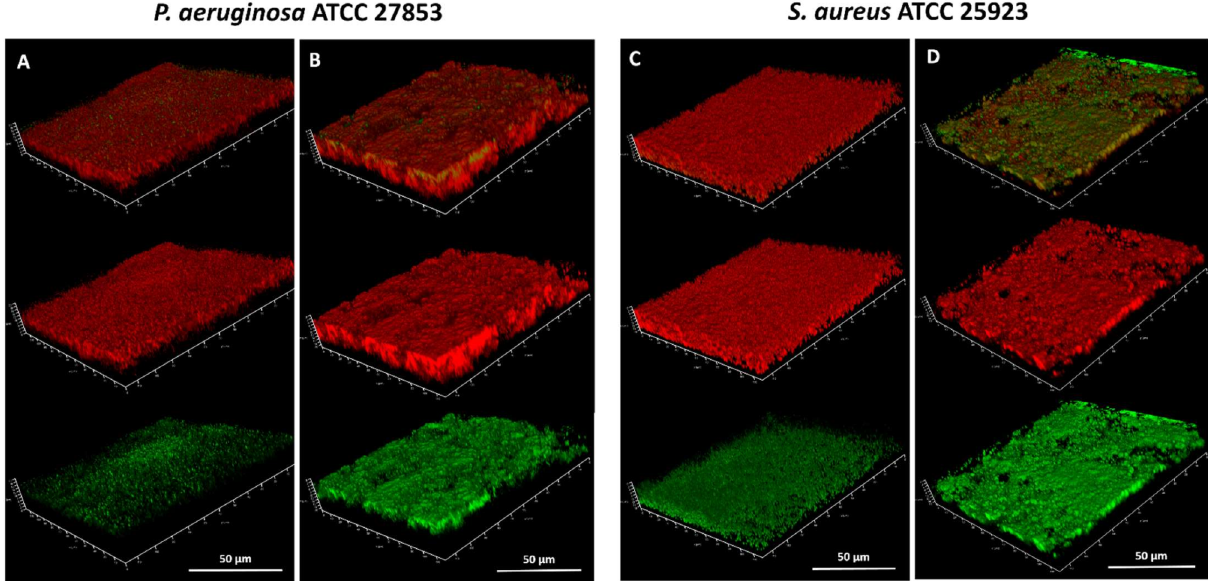
Figure 6. CLSM imaging of Pseudomonas aeruginosa ATCC 27853 (PA) and Staphylococcus aureus ATCC 25923 (SA) biofilms in situ after exposure to PHMG-Cl. Shown here are images of 3-day-old PA and SA biofilms after treatment with water ( A , C ) and 0.5% PHMG-Cl ( B , D ). PI (red signal) and SYBR Green (green signal) were used to visualize eDNA, including the eDNA released from damaged cells, and SYBR Green to visualize the intracellular DNA of living (metabolically active) cells with undamaged membranes. In each panel, the top orthogonal view shows the combined PI and SYBR Green signal. The PI signal is shown in the middle view and the SYBR Green signal in the bottom view. The red/green channel pixel sum ratios are ( A ) 1.43, ( B ) 2.28, ( C ) 2.76, and ( D ) 1.15. The SYBR Green appears enhanced after PHMG-Cl treatment (bottom view in B and D ) because the biocide damages the cell wall and membrane, allowing more SYBR Green to enter the cell and bind intracellular DNA.